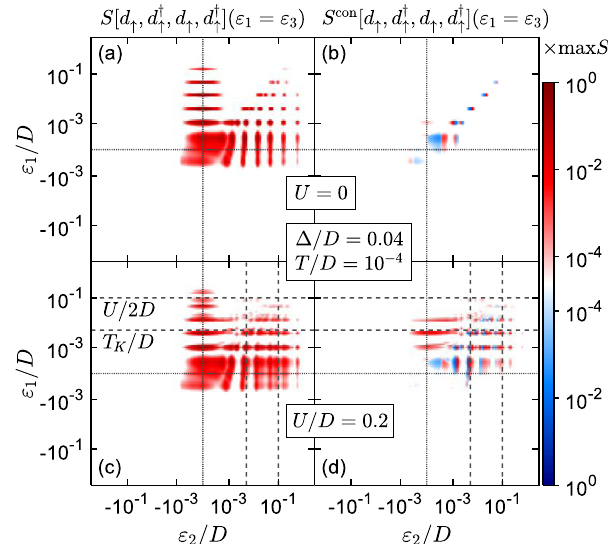
FIG. 3. Analogous to Fig. 2, but for a same-spin 4 p PSF S ½ d ↑ ; d † ↑ ; d ↑ ; d † ↑ (cid:2)ð ε Þ , shown as a function of ε 1 and ε 2 at ε 3 ¼ ε 1 . In (b), the narrow adjacent red and blue regions along the diagonal ε 1 ≃ ε 2 > 0 reflect contributions from S and S dis which fail to cancel fully, due to rebinning involved for S dis